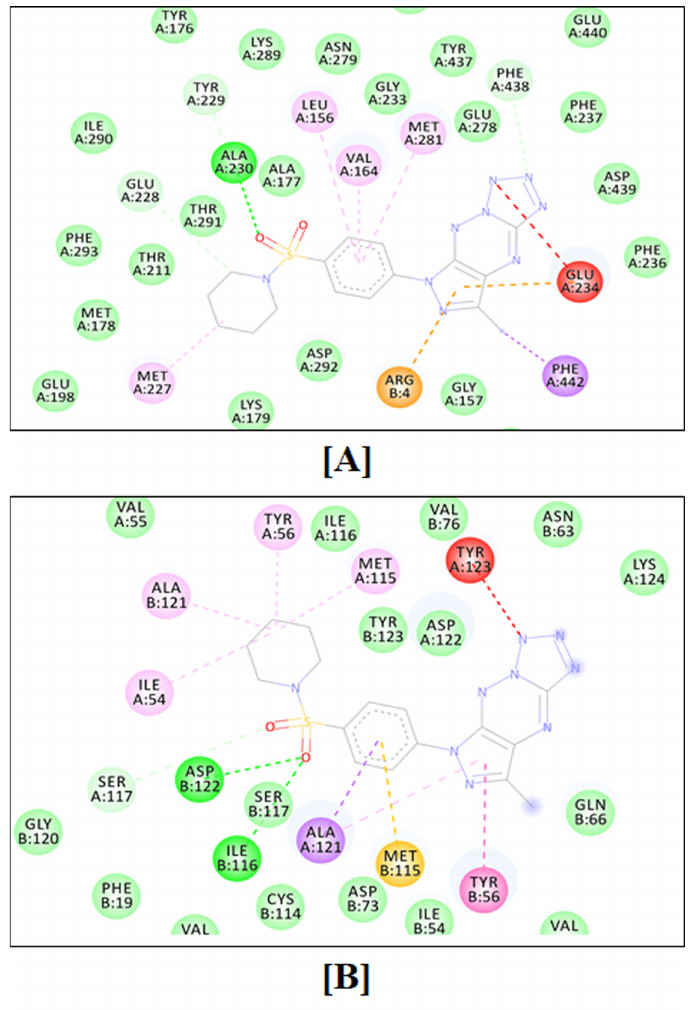
Figure 13. Two-dimensional binding conformation of the triazine sulfonamide analog MM139 against human AKT1 ( A ) and PD-L1 ( B